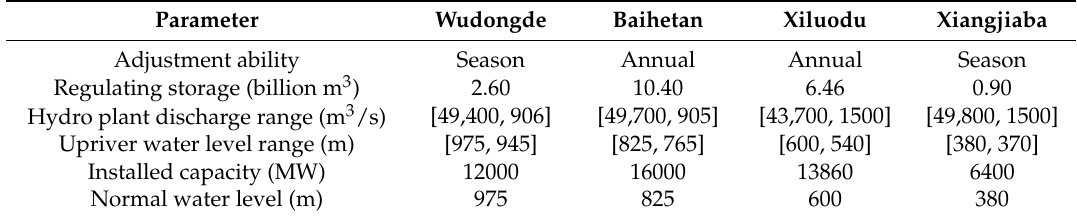
Figure 5. The location of the Jinsha River Basin in China. Table 4. The main parameters of four large hydropower stations in Jinsha